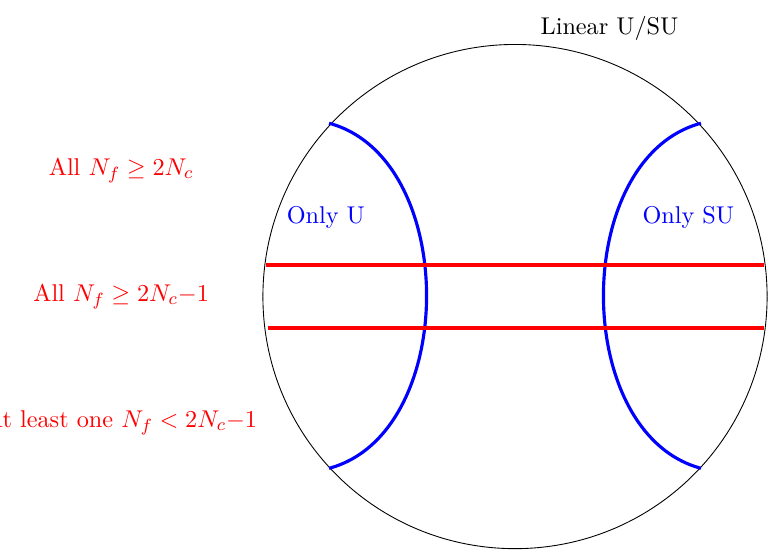
Figure 1 . Venn diagram of the different types of quivers discussed in this paper. N c stands for the gauge rank of a node in the quiver, while N stands for the number of hypermultiplets connected f to it. The circle represents all linear quivers with unitary and special unitary gauge groups, and arbitrary numbers of flavors. In the left blue region, where all gauge groups are unitary, magnetic quivers can be computed using D3-D5-NS5 systems (One can also use (fully) locked brane webs), while in the right blue region, where all the gauge groups are special unitary, one can use 5-brane webs. In the generic (middle) region, brane webs with lockings are needed. In the top region, all gauge groups have enough matter to ensure that the magnetic quiver is a 3d mirror theory. Below this, in the middle stripe, the same applies up to free hypermultiplets (see discussion in section 4) if only one gauge node has N = 2 N 1 ; if two gauge nodes or more satisfy this equality, the f c − situation is more complex, see section 4. In the last region, a collection of effects can happen: the Higgs branch can contain one cone or more, and the Higgs ring can possibly contain nilpotent elements, see table